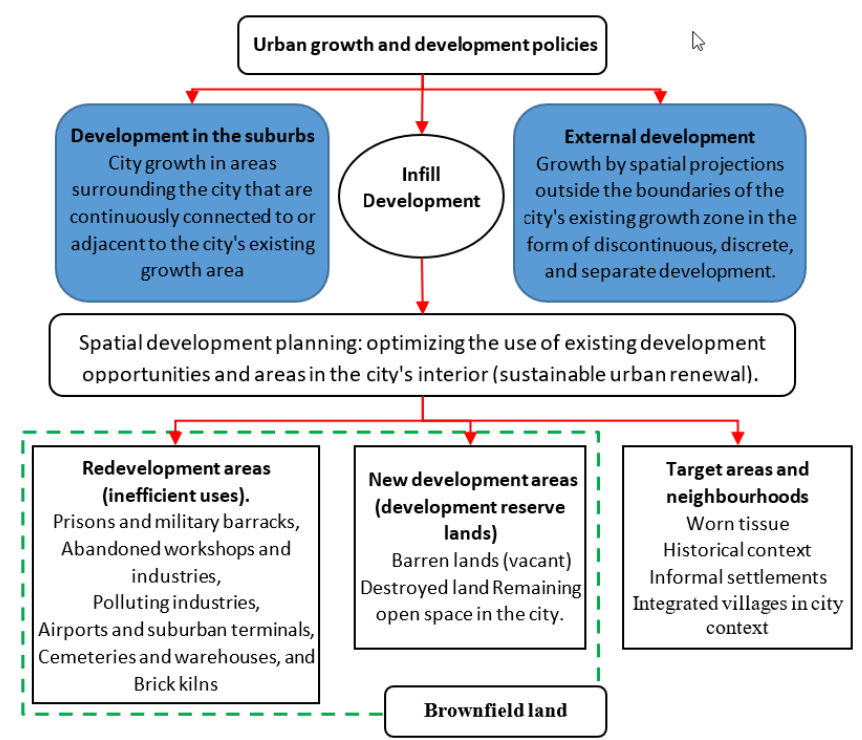
Figure 1. Infill development strategy conceptual framework.